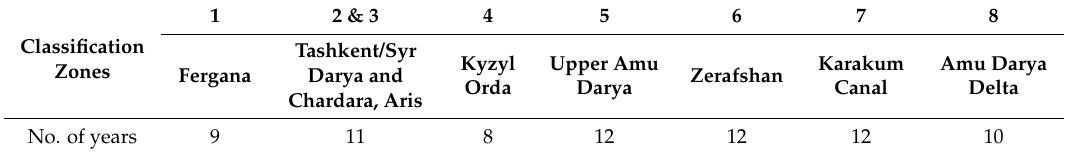
Table 2. Number of years, for which Landsat-7 ETM+ reference data was available for generating a HR map. Samples of CZs 2 and 3 were merged due to the comparable low number of reference data sets in CZ 3.